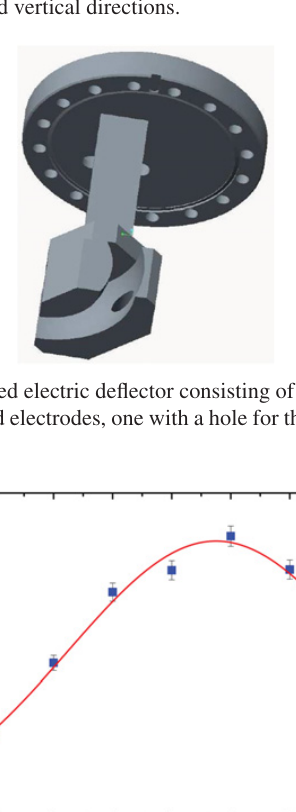
Figure 13. Sketch of a 90 ◦ electric deflector consisting of two electrodes with curvature radii R 1 and R 2 , r being the reference particle radial coordinate. The deflector focuses both in horizontal and vertical directions.